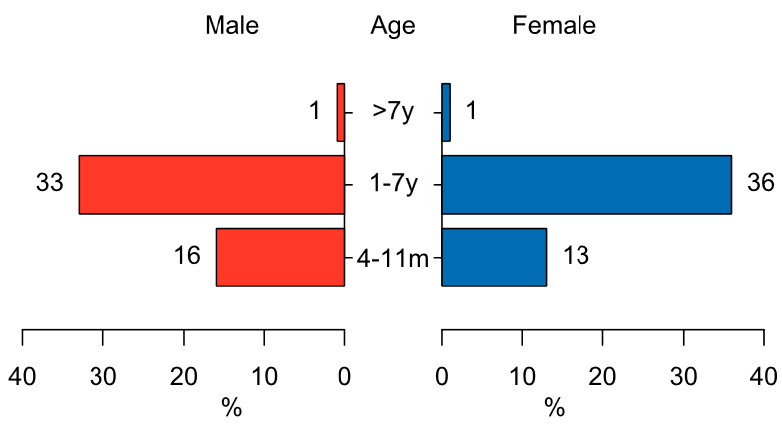
Figure 2. Age and sex distribution of surveyed dogs older than 3 months. Note that age categories are not distributed equally.